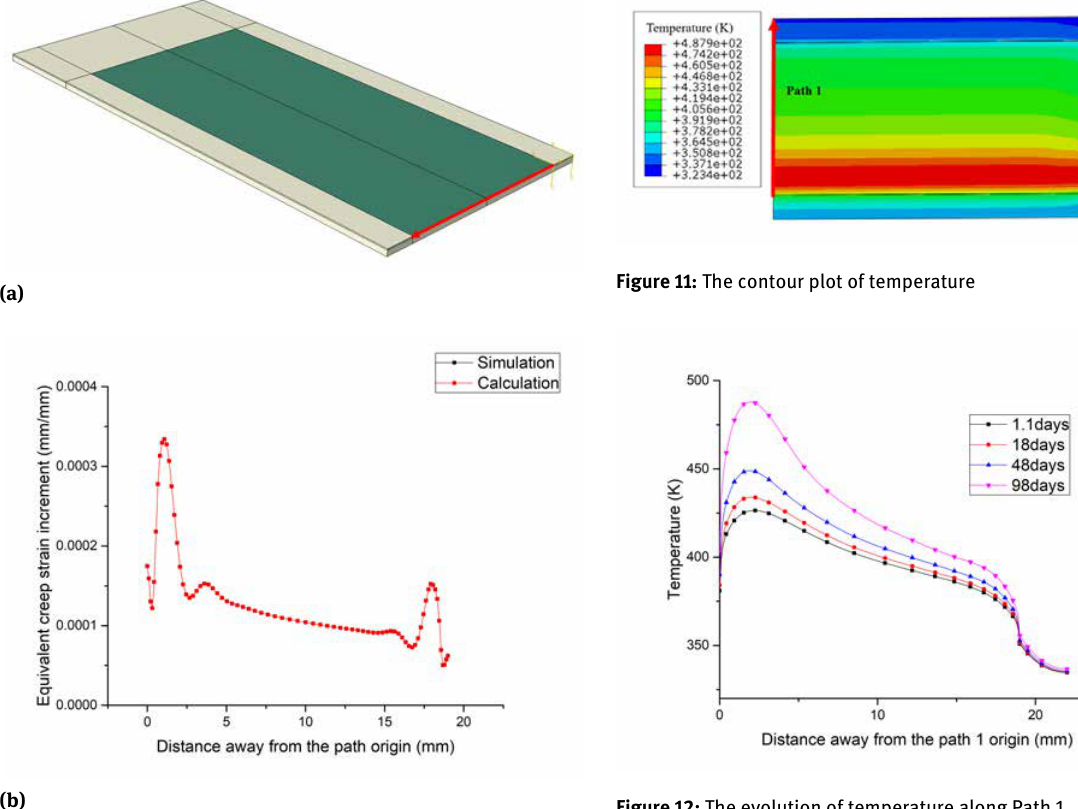
Figure 10: Verification of fission-induced creep effect